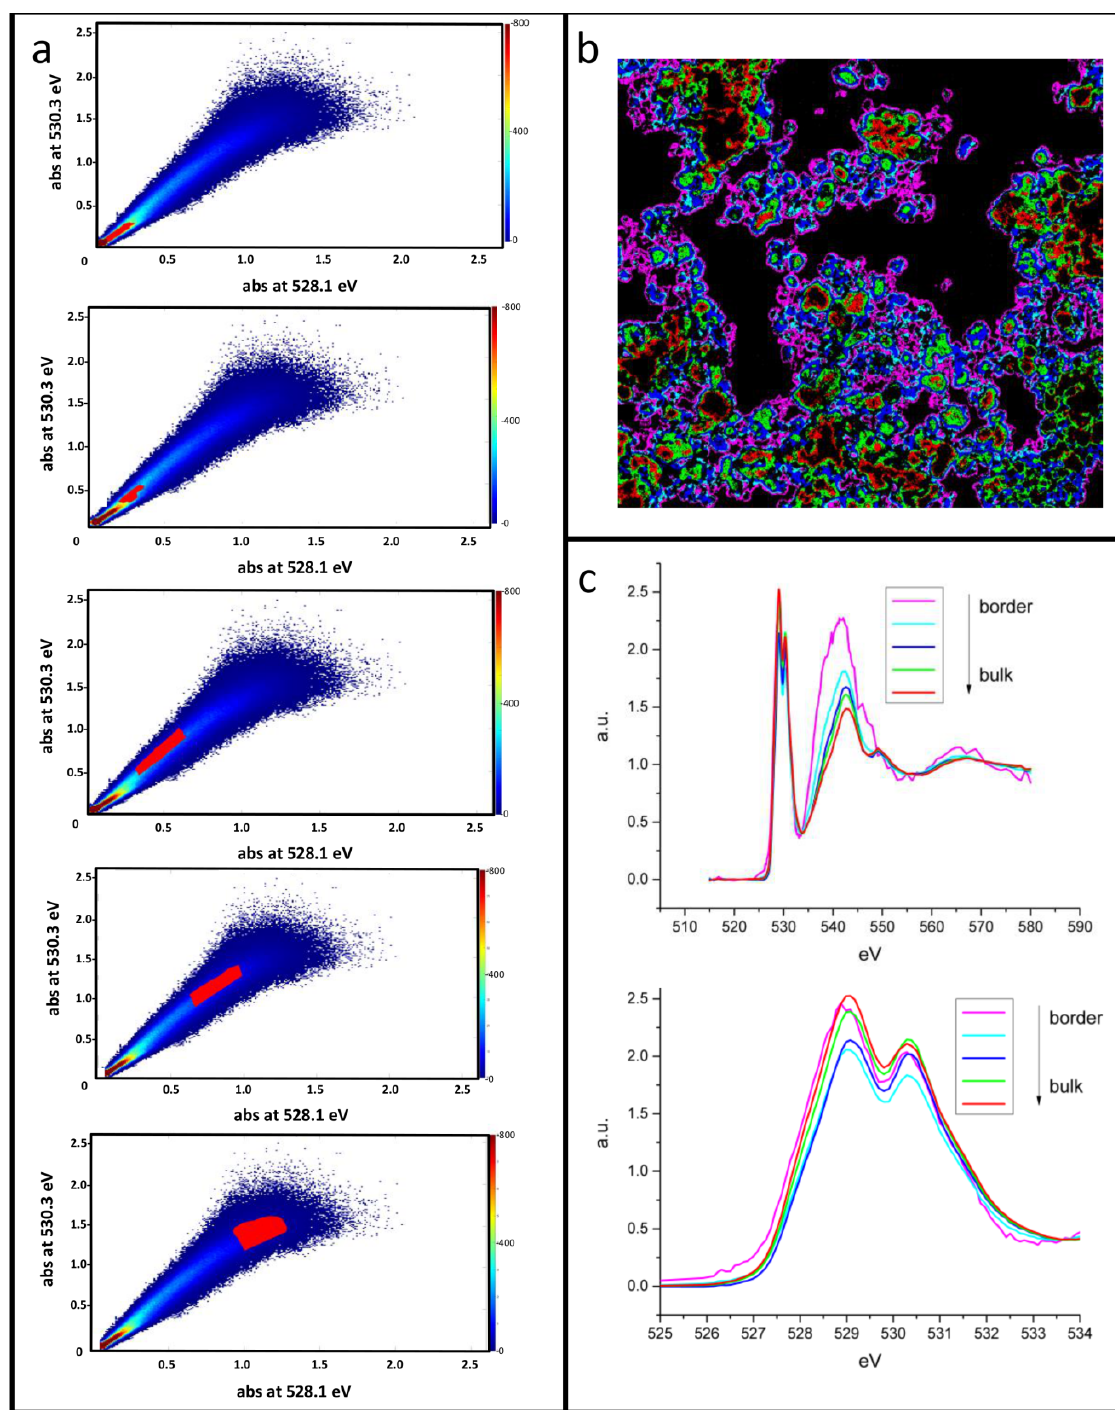
Figure 8. Same as Figure 7 on the fully charged Li 1.2 Mn 0.56 Ni 0.16 Co 0.08 O 2 electrode material (P05).